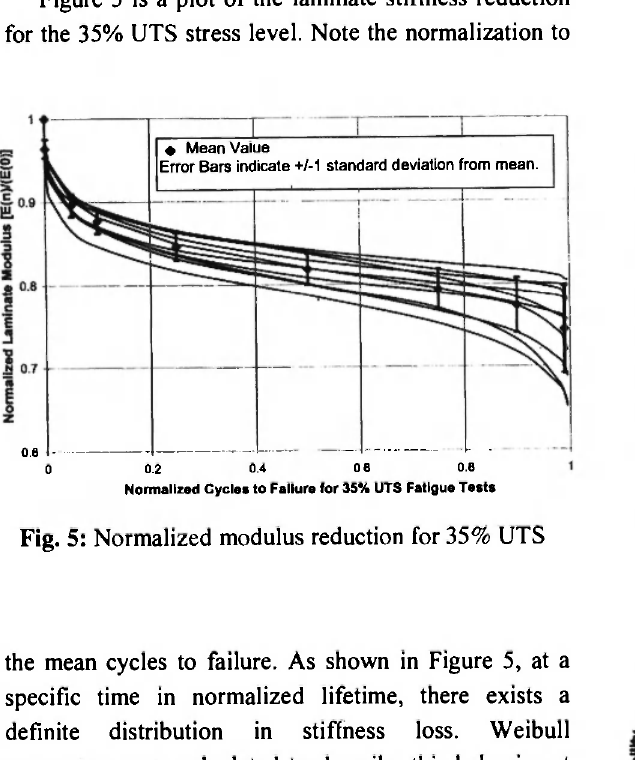
Fig. 5: Normalized modulus reduction for 35% UTS